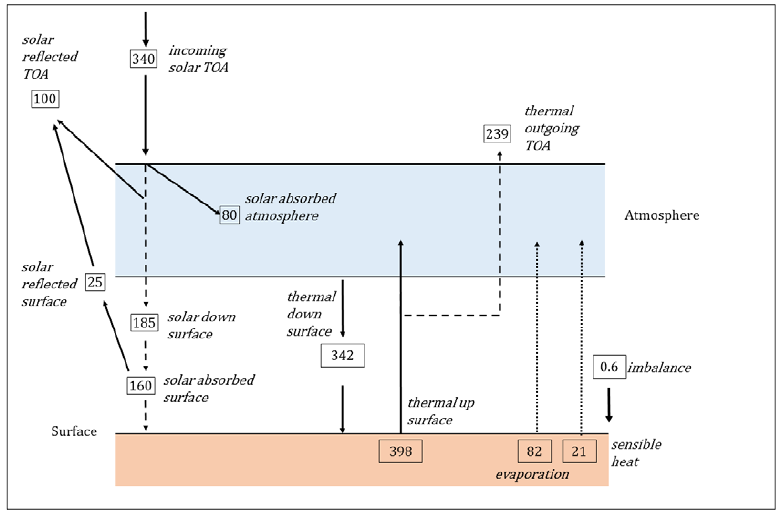
Figure 5. Observation-based land and sea energy budget diagram, modified after Wild et al. (2015) [4]. All of the units are in W/m 2 . Table 1. Comparison of fluxes reported by Wild et al. [4] and calculated using the adiabatic radiative model. Values for the variables are derived directly from Wild et al. using the “Best Estimate” values, and calculated in the adiabatic model using the formulae in the Value